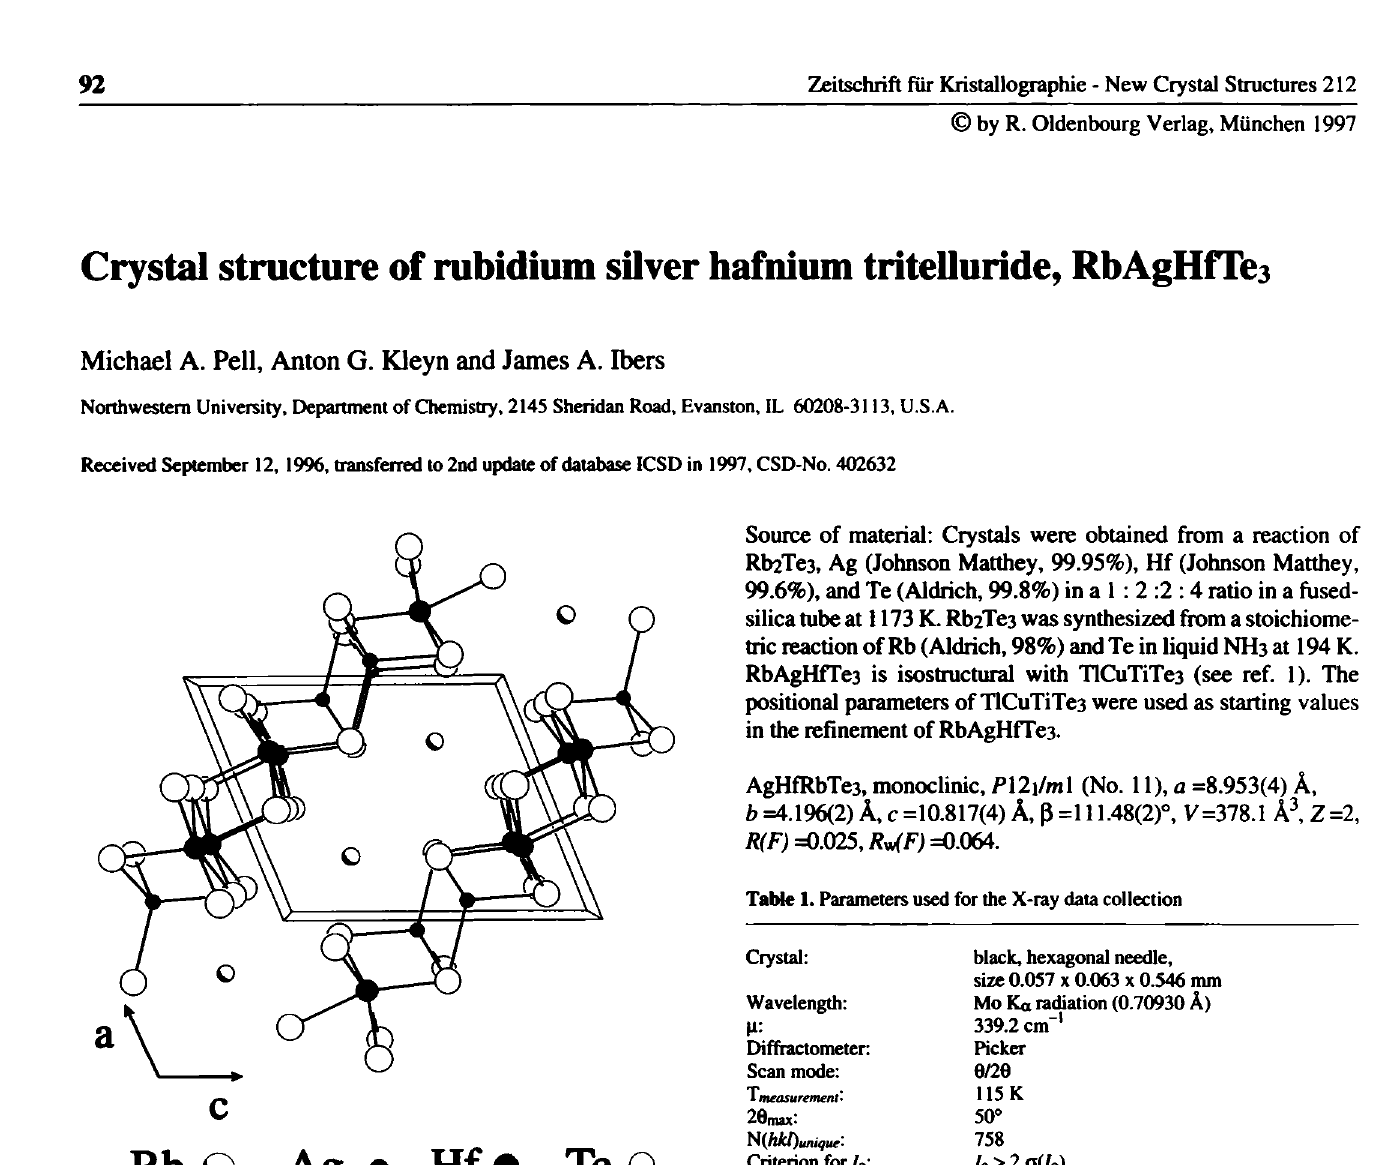
Table 2. Final atomic coordinates and displacement parameters (in Â 2 ) Atom